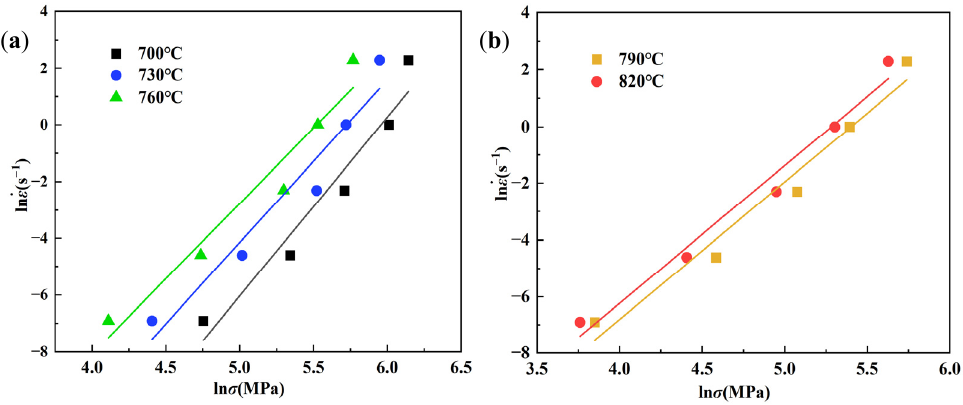
Figure 3. Curves of ln ε . ε − σ at different phase fields: ( a ) α + β and ( b ) β .